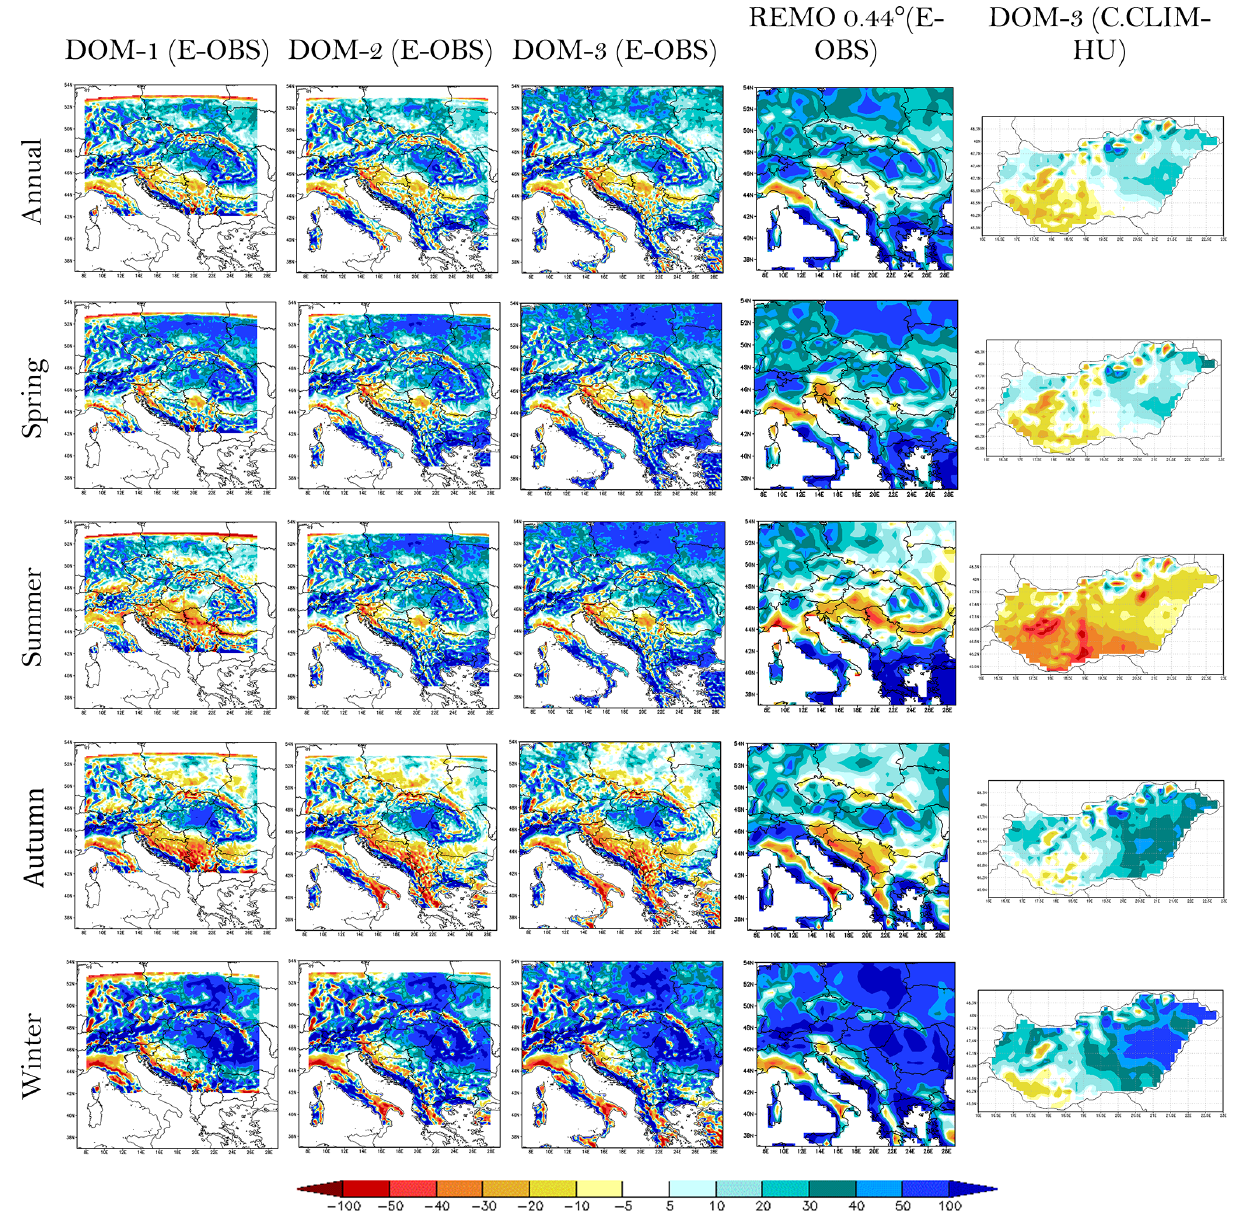
Figure 4. The relative annual and seasonal precipitation bias (%) of the different 10km resolution REMO model simulations and the REMO_0.44 compared to the E-OBS and of the DOM-3 experiment with reference to CarpatClim-Hu dataset. Period: